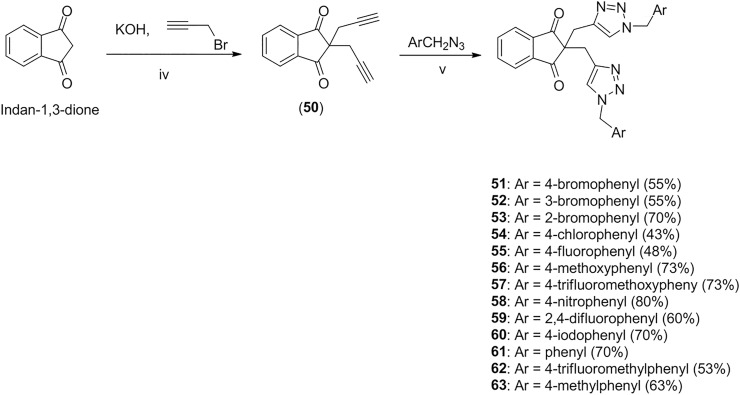
Synthesis of compounds 51–63.iv) aqueous KOH, then propargyl bromide, 40 oC, 24h; v) sodium ascorbate (40 mol%), CuSO4·5H2O (20 mol%), CH2Cl2/H2O (1:1 v/v), 2h.